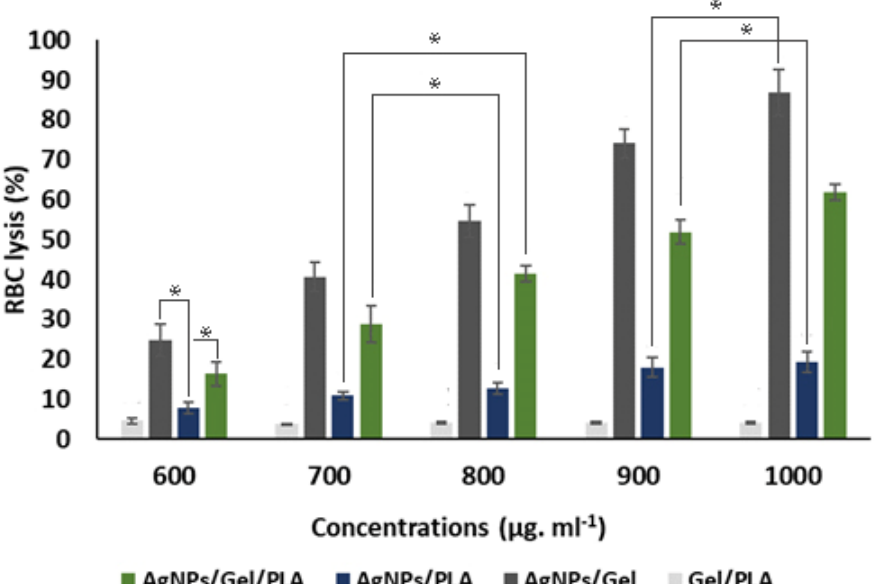
Figure 5. RBC lysis activity of Gel/PLA, AgNPs/Gel, AgNPs/PLA and AgNPs/Gel/PLA mats for different textiles concentrations (600 µ g.mL − 1 –1000 µ g.mL − 1 ) using PBMC cells. The experiments were repeated in triplicate and the control sample was free PBS, which showed zero% RBC lysis. Asterisks indicate statistically significant differences using Duncan’s test (* p < 0.05).